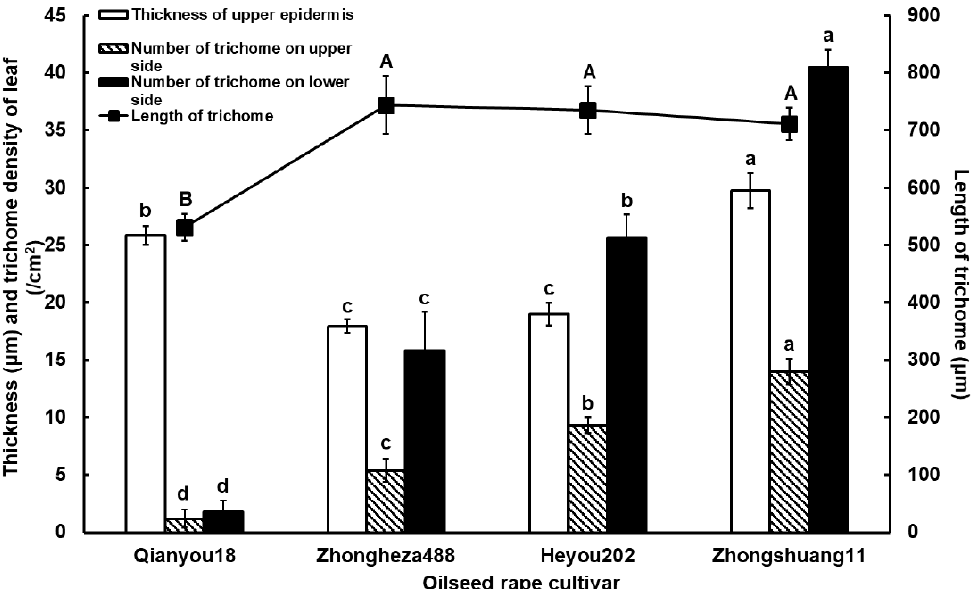
Figure 2. The leaf surface characteristics of four oilseed rape cultivars. Data were analyzed by ANOVA followed by the unrestricted least significant differences (LSD) test. The significance level was set at P < 0.05. Bars represent stand error (SE). The same lowercase letters above the columns of the same color represent no significant differences among the tested cultivars, and the same uppercase letters above the black squares represent no significant differences among the tested cultivars.